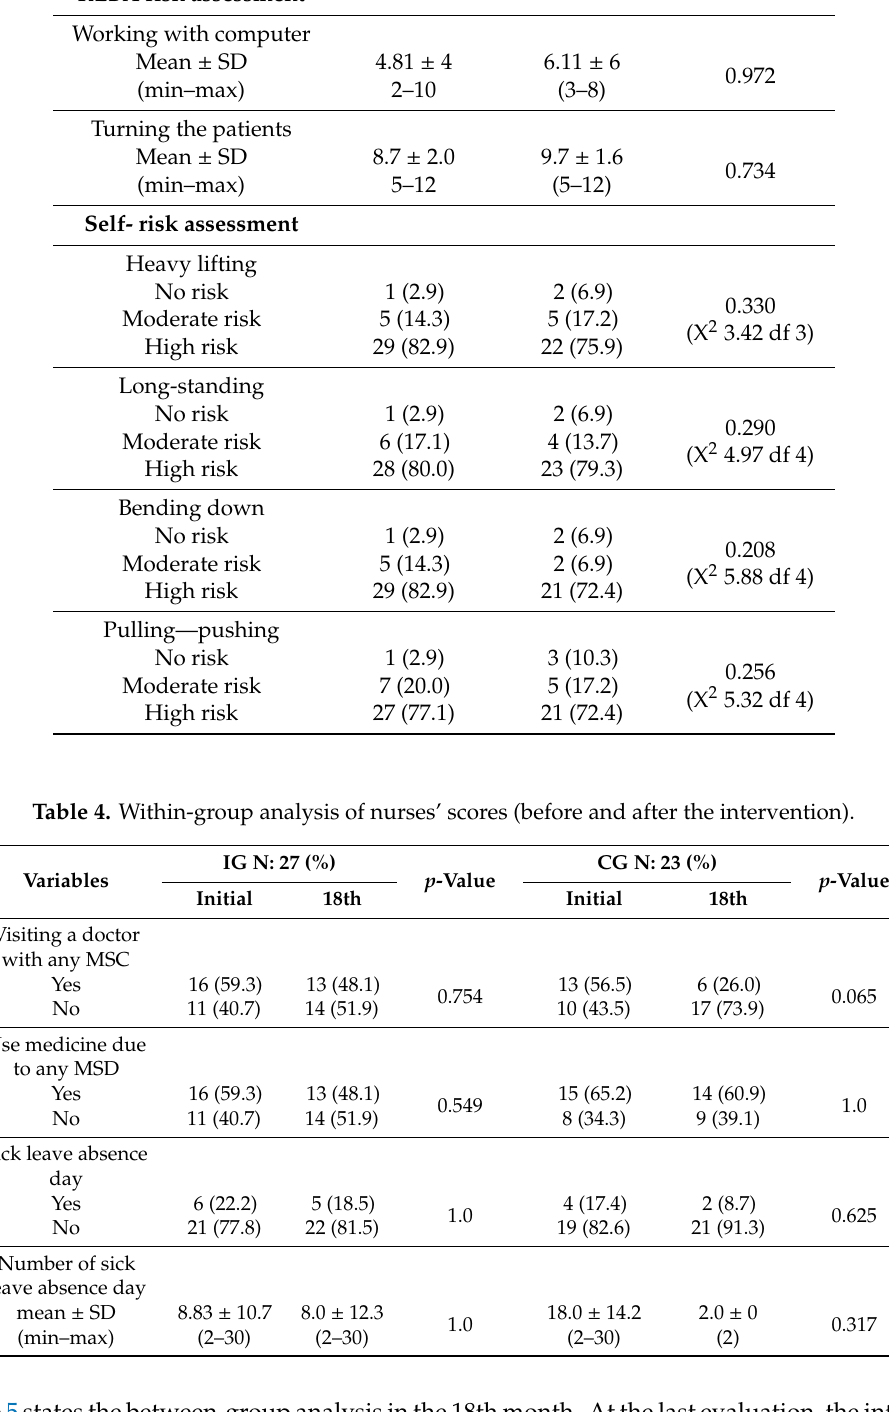
Table 5 states the between-group analysis in the 18th month. At the last evaluation, the intervention and CG were similar in terms of visiting any doctor due to MSC, the number of sick leave absence days, and self-ergonomic-risk assessment in terms of heavy lifting, long-standing, bending down and pulling-pushing. There was an increase in ergonomic risk perception in both groups. In the initial assessment, 80% of the nurses evaluated a high risk for long-standing, while in the 18th-month evaluation this rate increased to 96.3% in IG (not statistically significant) This increased in the CG